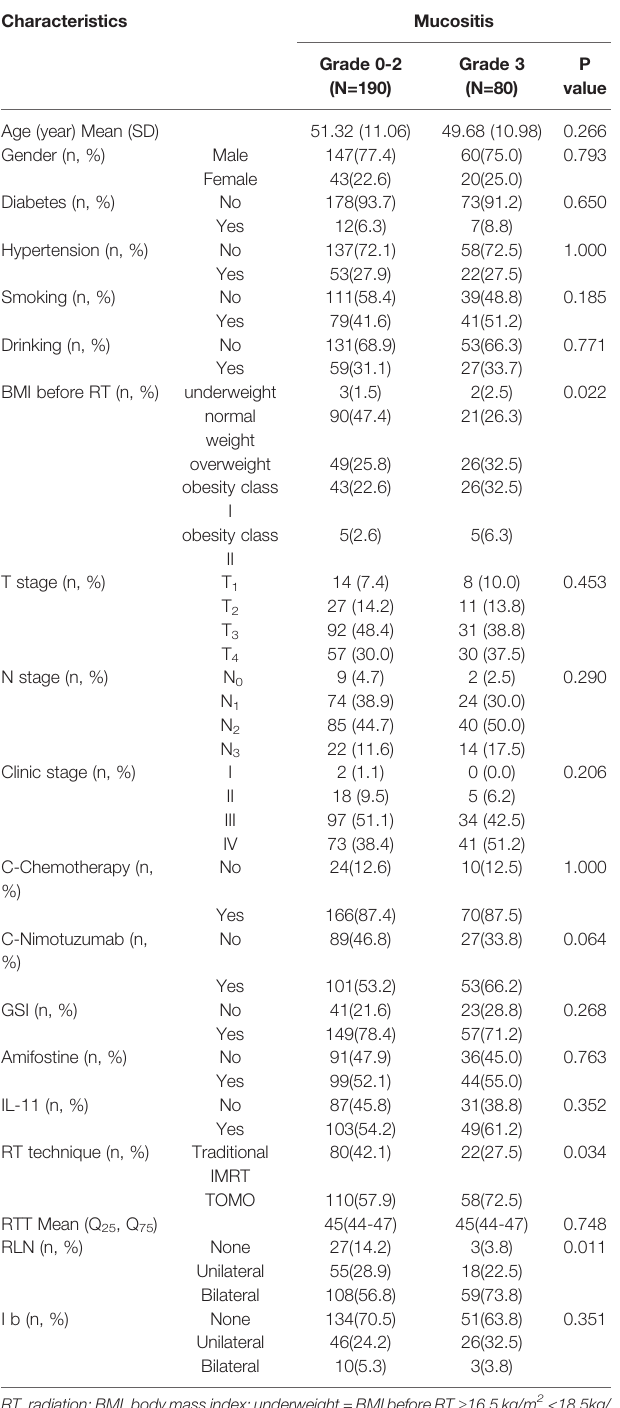
TABLE 1 | Clinic characteristics of 270 nasopharyngeal carcinoma patients.